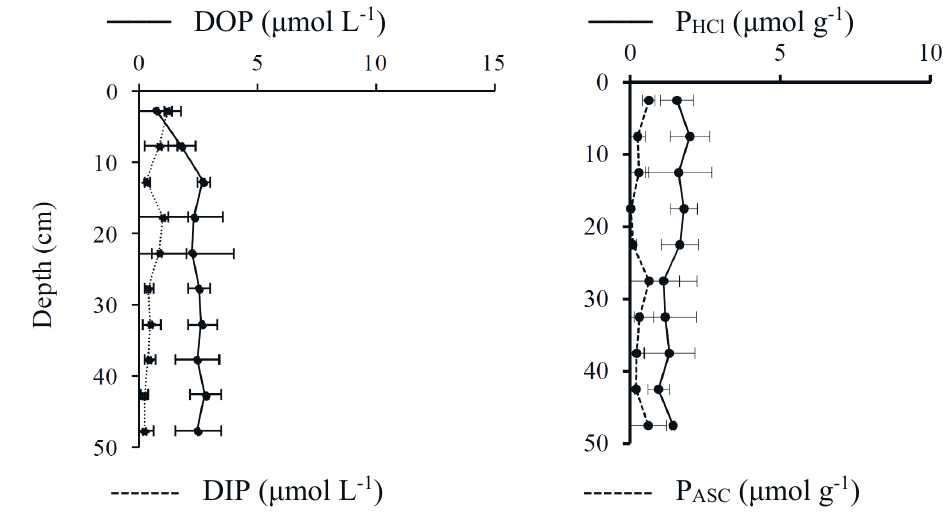
Figure 7. Mean concentrations ( n = 3) and standard deviation of dissolved organic and inorganic phosphorus (DOP and DIP), and solid phosphorus phases extracted by ascorbate (P ASC ) and by HCl 1N (P HCl ) in sediments of the three vegetation